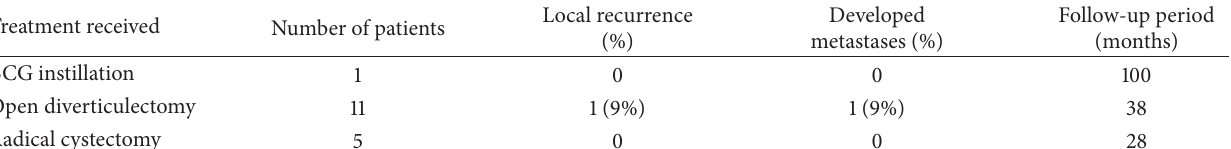
Table 2: Data relating to intradiverticular bladder tumour staging, follow-up, and survival.